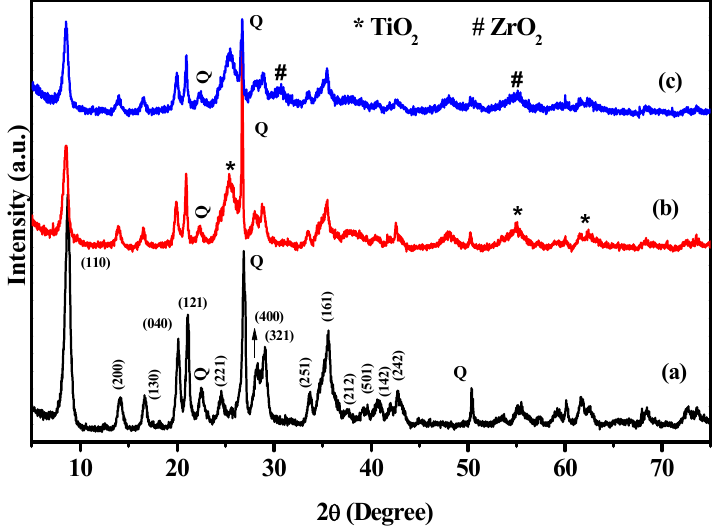
Figure 1. X-ray di ff ractograms for ( a ) Pal, ( b ) TiO 2 –Pal, and ( c ) ZrO 2 –TiO 2 Figure 1. X-ray diffractograms for ( a ) Pal, ( b ) TiO 2 –Pal, and ( c ) ZrO 2 –TiO 2 –Pal.